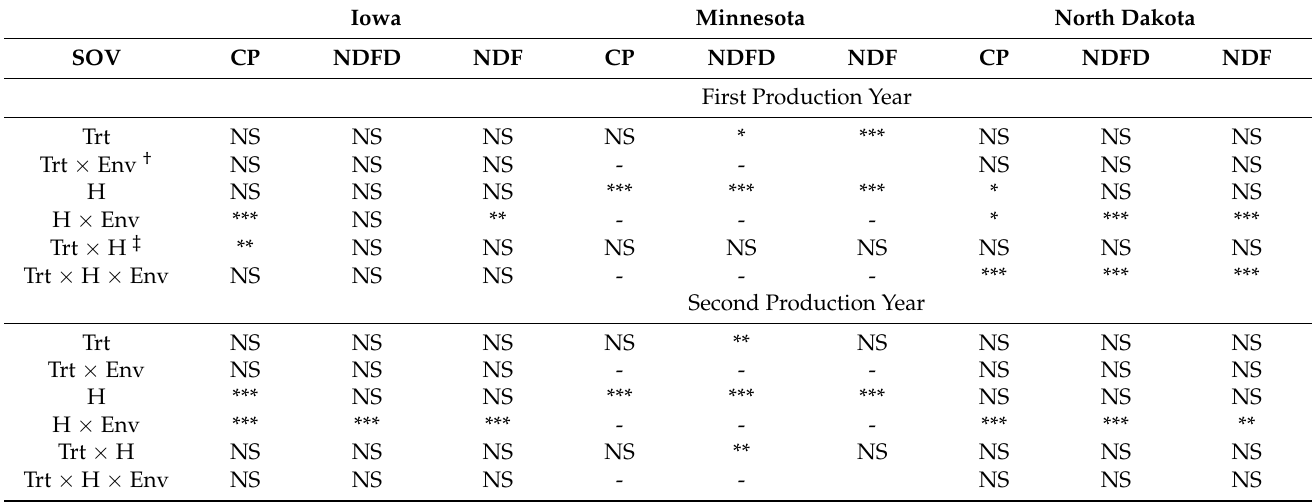
Table 10. Sources of variation and significance of effects for crude protein (CP), neutral detergent fiber digestibility (NDFD), and neutral detergent fiber (NDF) of alfalfa in the first and second production year.